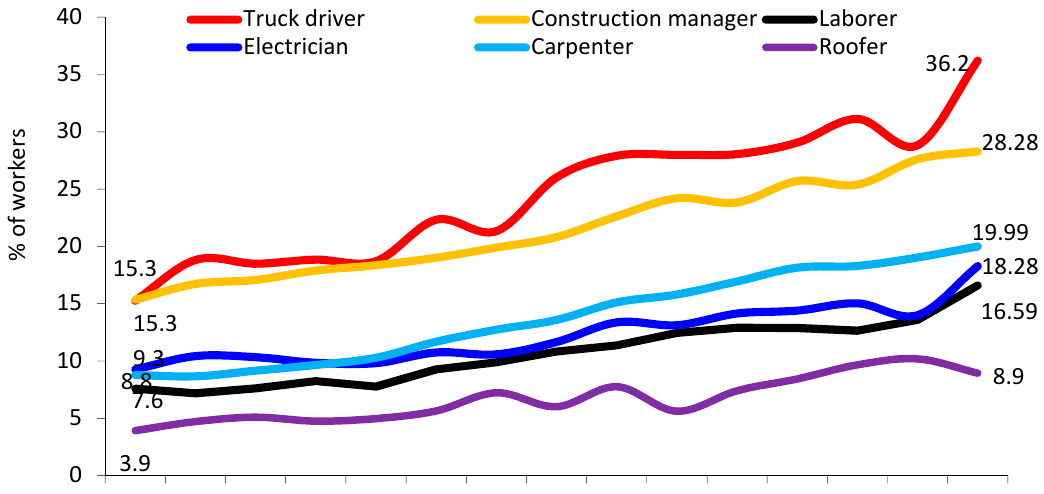
Figure 4. Construction workers aged 55+ years, selected construction occupations, 2003–2016 (All employment). Source: Current Population Survey, 2013–2017, Calculations by the authors. Age varied among worker subgroups. Self-employed workers were much older than wage and salary workers, with the median age at 49 (self-employed) and 40 (wage) in 2017, respectively ( p < 0.001). In 2017, the median age for union members was 42 years, compared with 39 years for non-union workers ( p < 0.001). Similarly, the average age was significantly different between union and nonunion workers for most occupations, except helpers (Table 2).